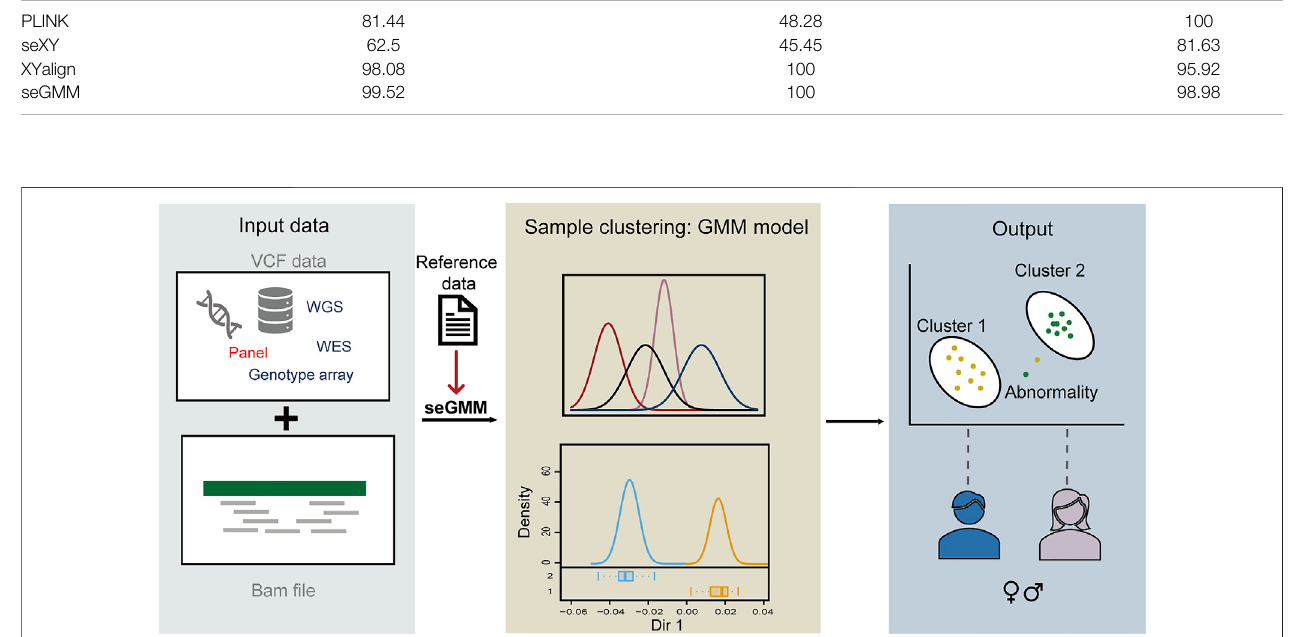
FIGURE 1 | Schematic diagram of seGMM. The seGMM tool automatically collects features from the input VCF and BAM fi les and builds the GMM model. The output of seGMM includes gender prediction results and identi fi cation of samples with abnormal sex